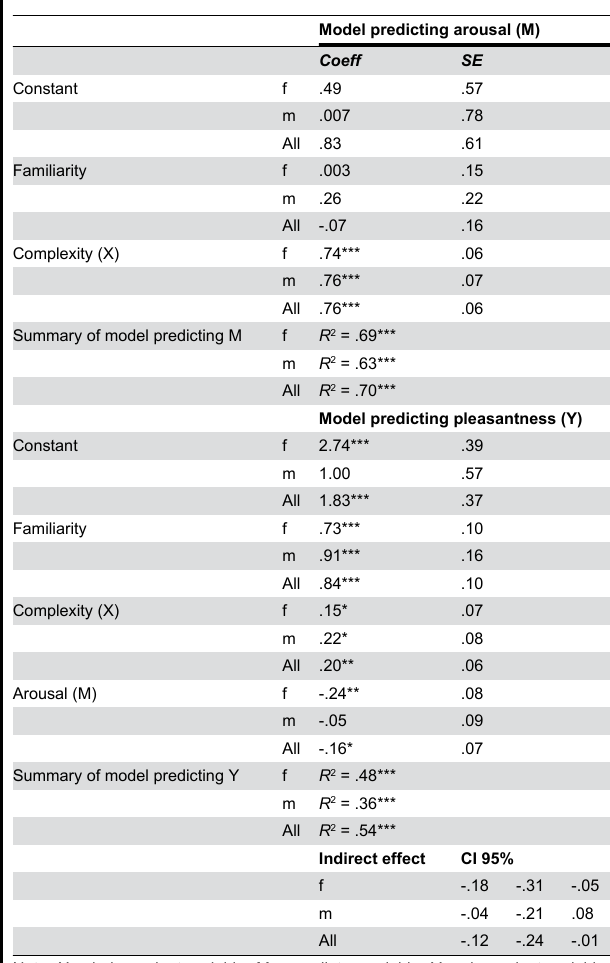
Table 13. Spearman’s rank-order correlations between ratings of familiarity, complexity, pleasantness and arousal in response to set of piano solo and piano trio excerpts (N ≥ 76, n ≥ 74, n ≥ 75). males females